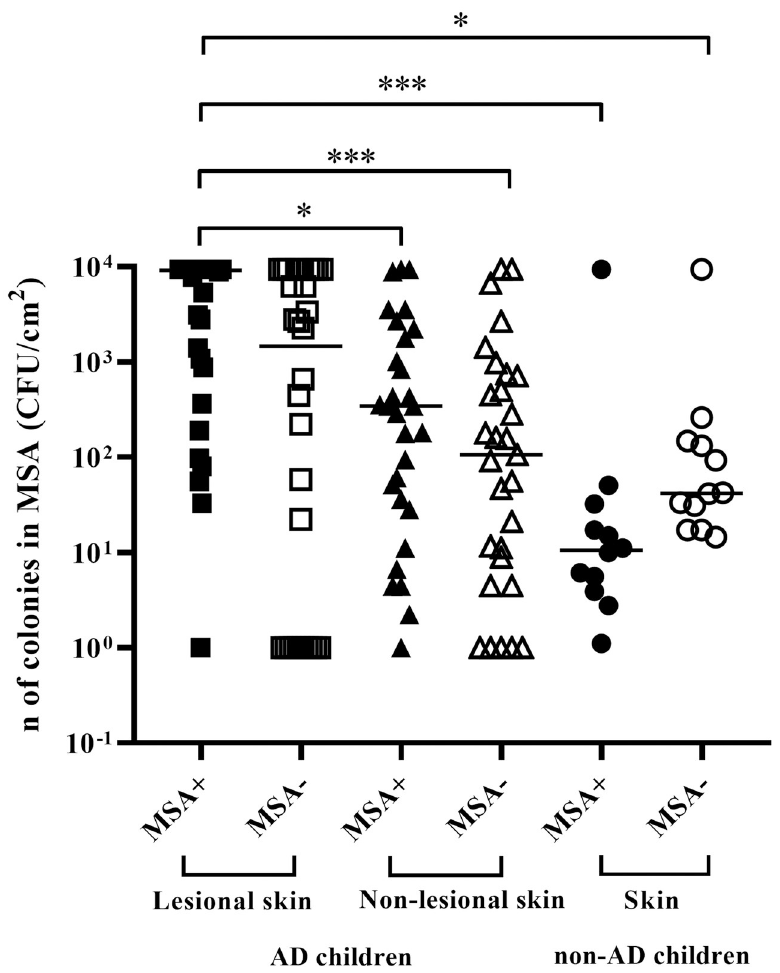
Fig 1. Mannitol fermenting and non-fermenting colony count from skin sites of children with and without atopic dermatitis. AD- Atopic dermatitis; CFU/cm 2 - Colony forming units per square centimeter; MSA- Mannitol salt agar; MSA+- Mannitol fermenting colonies; MSA- Mannitol non-fermenting colonies; n- Number. The horizontal bars indicate the median count for each group. The symbols � and ��� indicate, respectively: P < 0.05 and P < 0.001.